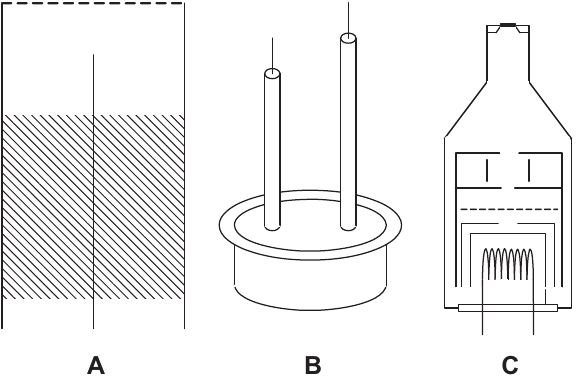
Figure 3 Different electron sources which have been used in a pulsed manner in IMS. Pulsed corona discharge in a point-to-plane configuration (A). The electrodes are in the center and at the outer housing. Without the mesh at the top it would be a point-to-ring configuration, which was actually the first ever used pulsed source. Pulsed corona discharge between two electrodes (B) and free elec- tron beams produced by a glowing filament inside a vacuum tube (C). With the help of electrical fields the electrons are accelerated through a ceramic foil serving as an exit window at the top of the